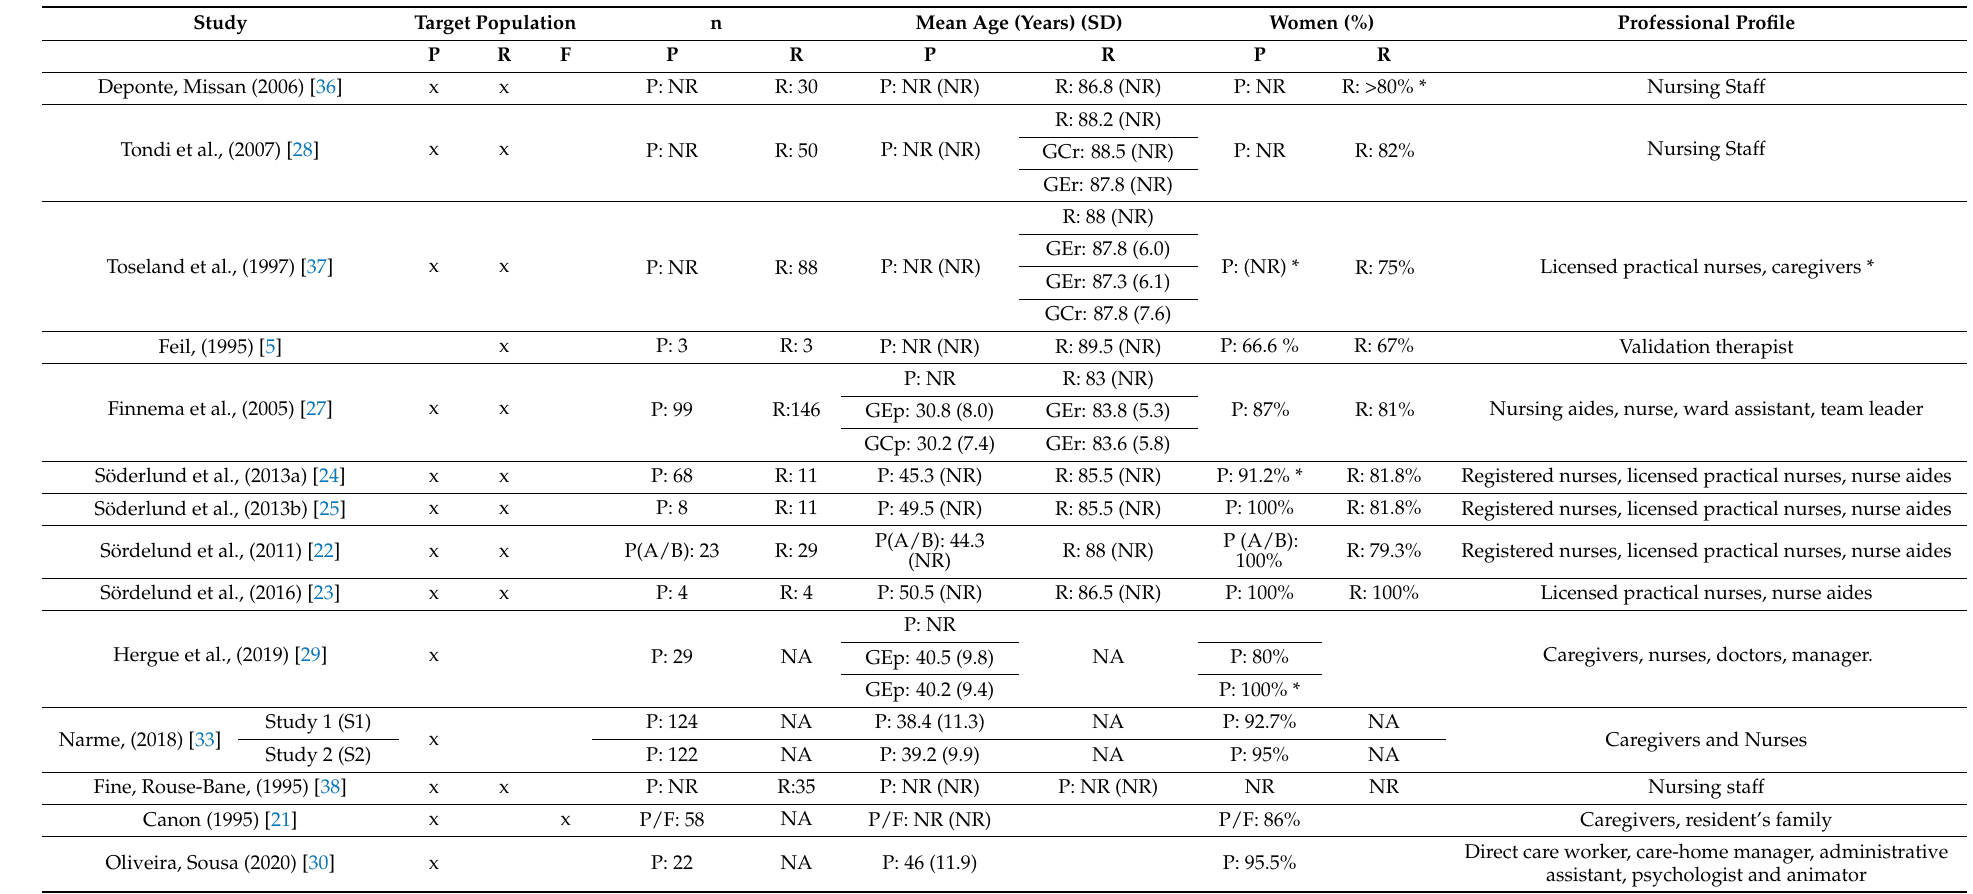
Table 2. Description of demographic characteristics and professional